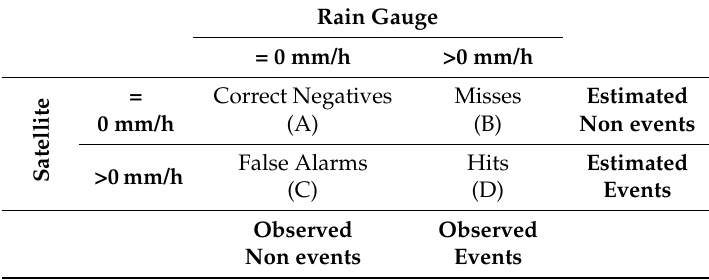
Table 1. An example of a contingency table usable to evaluate the quality of the